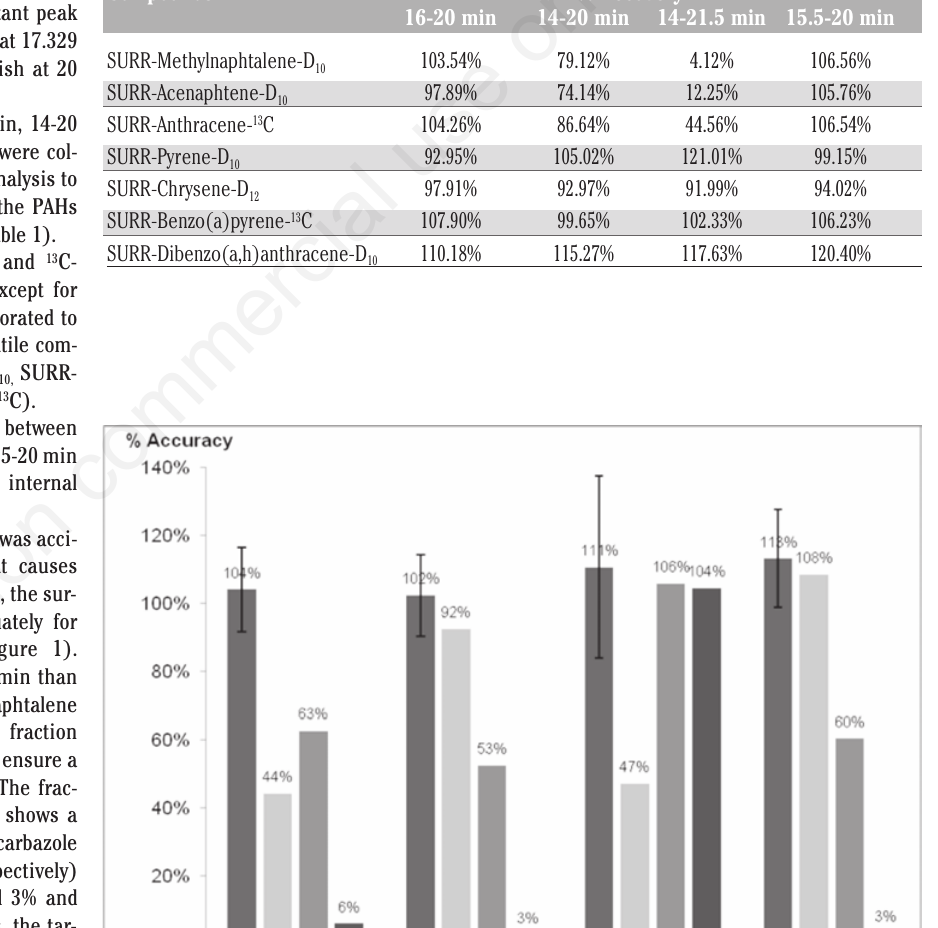
Table 1. Recovery percentage of the 13 C-labeled and deuterated internal standards for the four collections zones targeted for the polycyclic aromatic hydrocarbons. Compounds